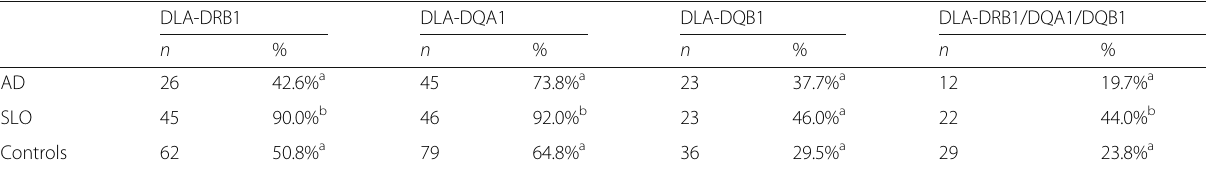
Table 4 Homozygosity across DLA class II genes in 233 Bearded collies (61 AD, 50 SLO and 122 controls). Different letters in the same column indicate statistical difference ( p < 0.05) in DLA homozygosity across health status